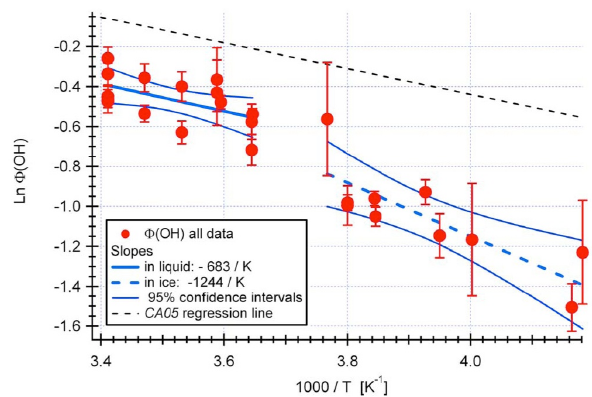
Fig. 19. Observed quantum yield of OH production from H 2 O 2 photolysis in water and ice (red dots). The slopes for our liquid (blue solid line) and ice (blue dashed line) results are statistically differ- ent at the 87% confidence level, and the slope for the ice data shows a stronger temperature dependence. Comparison to earlier data by Chu and Anastasio (2005) (black dashed line) shows that observed kinetics critically depend on the type of ice matrix: the slope for the liquid data is identical to the earlier results for liquid and solid phases (black dashed line). The slope for the shock-frozen ice data (blue dashed line) indicates a stronger temperature dependency than results for slowly frozen ice samples (black dashed line). Reprinted from Beine and Anastasio (2011). Copyright (2011) John Wiley and